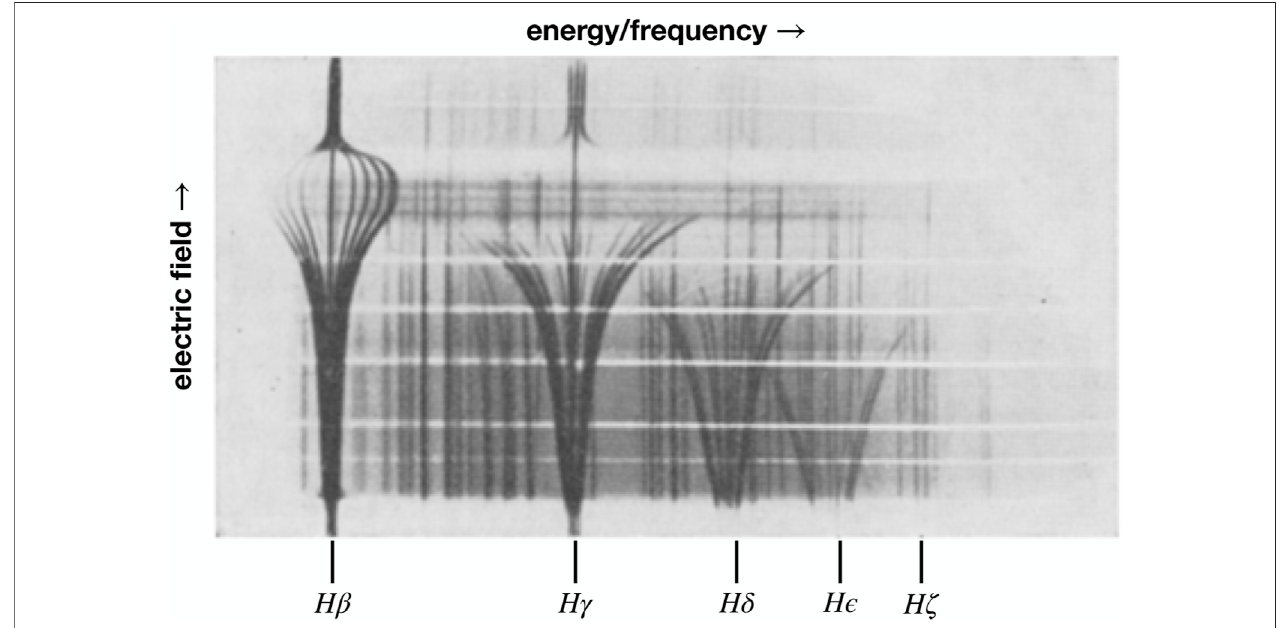
FIGURE 4 | The Stark effect of an applied electric fi eld on the splitting of hydrogen Balmer lines as measured by von Traubenberg and Gebauer (1929), Gebauer and von Traubenberg (1930) and von Traubenberg et al. (1930). Taken from von Traubenberg et al. (1930).